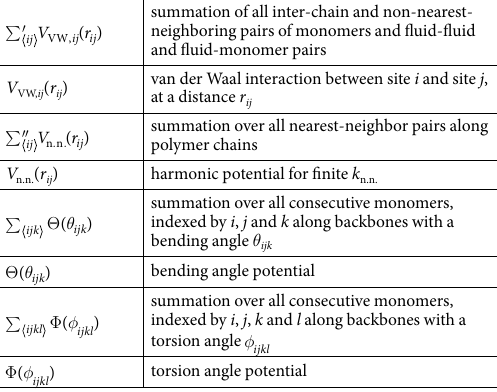
Table 1. List of Interaction Potentials.